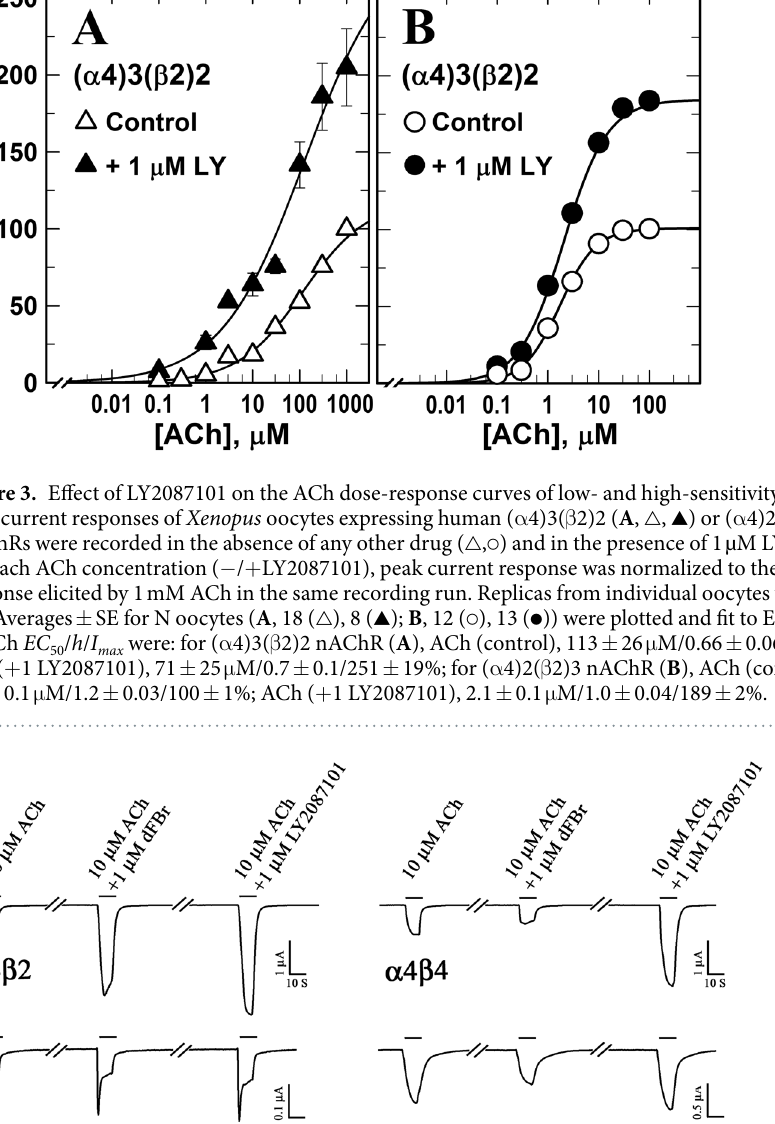
Xenopus oocytes injected with a mix of RNA encoding α 4 containing these point mutations and WT β 2 subunit RNA at a ratio of 8:1 to favor the expression of the 3 α 4:2 β 2 stoichiometry. As shown in Fig. 5A, mutations of these amino acids had no effects on LY2087101 potentiation of ( α 4)3( β 2)2 nAChR. To quantify the effect of amino acid mutations on LY2087101 potentiation, we calculated for WT and for each mutation a potentiation ratio PR , the ratio of the peak current amplitude induced by an agonist at its EC 10 (10 µ M ACh for ( α 4)2( β 2)3 nAChR) in the presence of 1 μ M PAM (LY2087101 or dFBr) relative to the peak current amplitude elicited by the agonist at its EC 10 alone (Table 1). LY2087101 potentiation ratios for ( α 4)3( β 2)2 nAChRs containing point mutations within the α 4 extracellular domain mutation to the corresponding amino acids in the α 3 subunit ( α 4L63I, α 4R65H, α 4G67E, α 4E92I, α 4H94N, α 4H142L, α 4R148E, α 4Q150T, or α 4T152I) were similar or higher than that for WT ( α 4)3( β 2)2 nAChR ( PR WT = 4.1 ± 0.3) and significantly different from no potentiation ( PR = 1 ) with a P values of < 0.001 in one-way analyses of variance (ANOVA) test. These results indicate that the extracellular domain of α 4 subunit has little, if any, direct interaction with LY2087101.